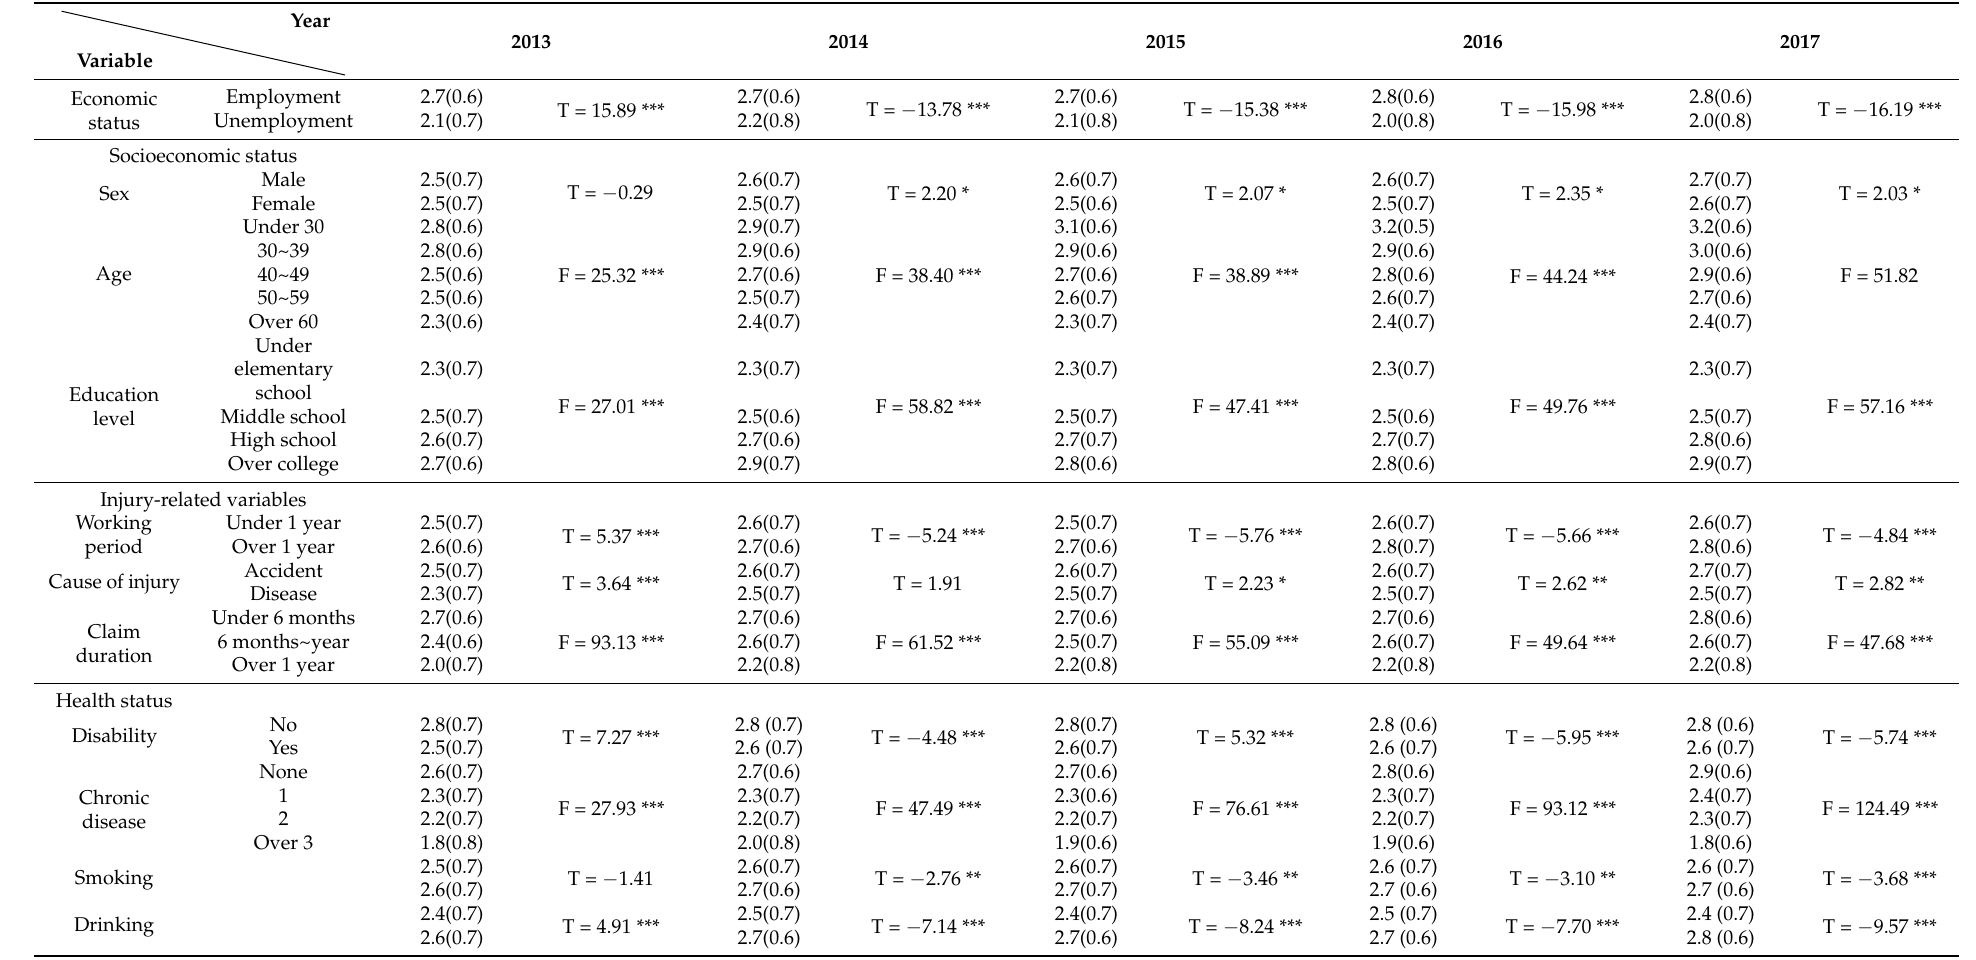
Table 2. Overall health status based on the general characteristics of the research